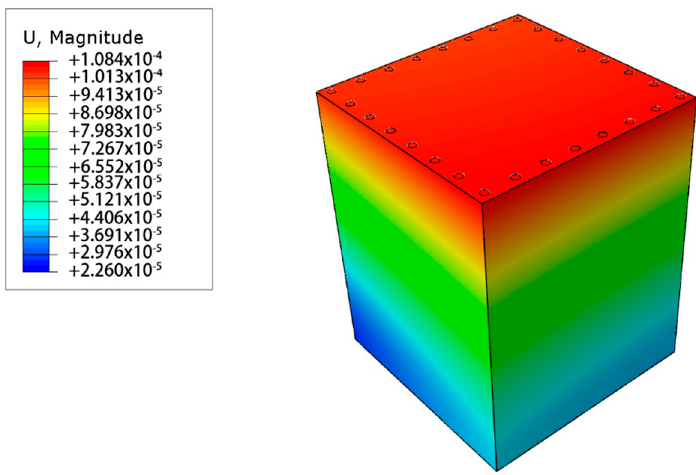
Figure 10. Displacement distribution of the steel-reinforced concrete column in the case of axial stress.